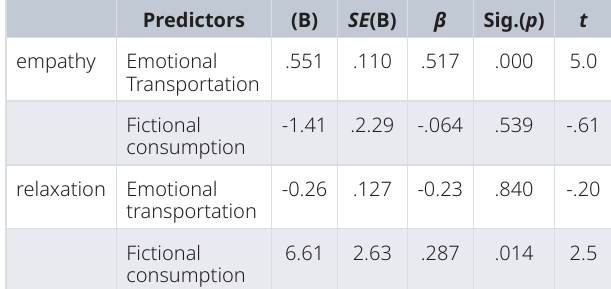
Table 6. Multiple regression for emotional consumption and fictional consumption predicting empathy and